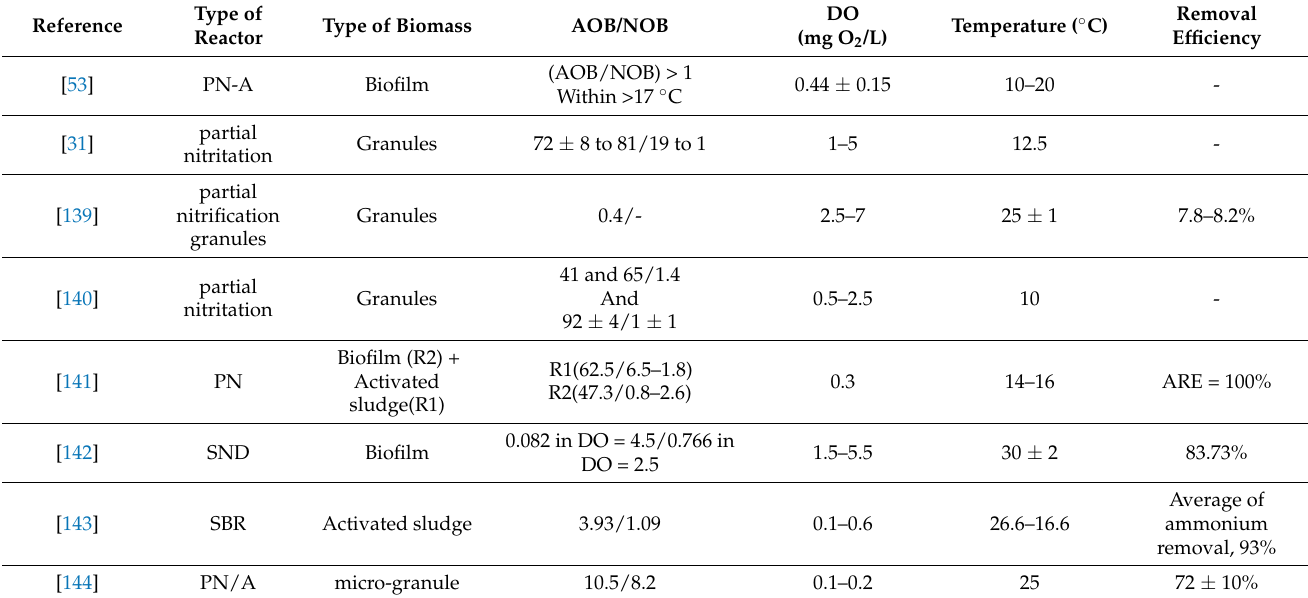
Figure 8. Interactions between different operational factors and ammonium oxidizing bacteria (AOB) ‐ nitrite oxidizing bacteria (NOB) competition. Table 5. The introduction of different biomasses retention strategies in literature.